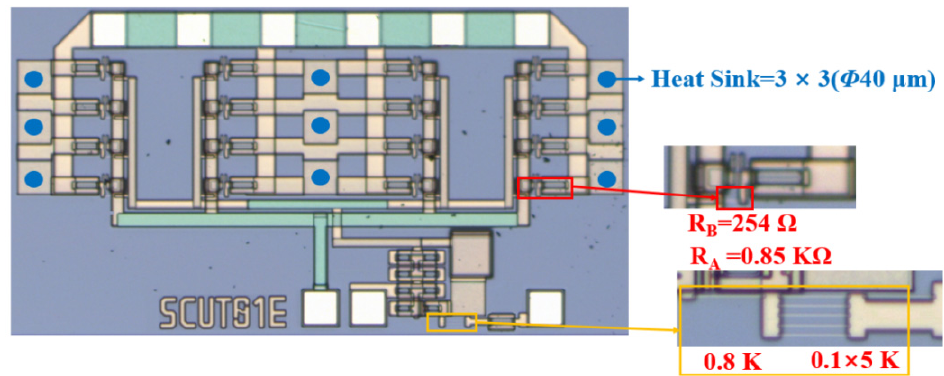
Figure 6. Die photo of PA with the proposed ZTAT current. Table 1. Comparison of the proposed bias circuit with current